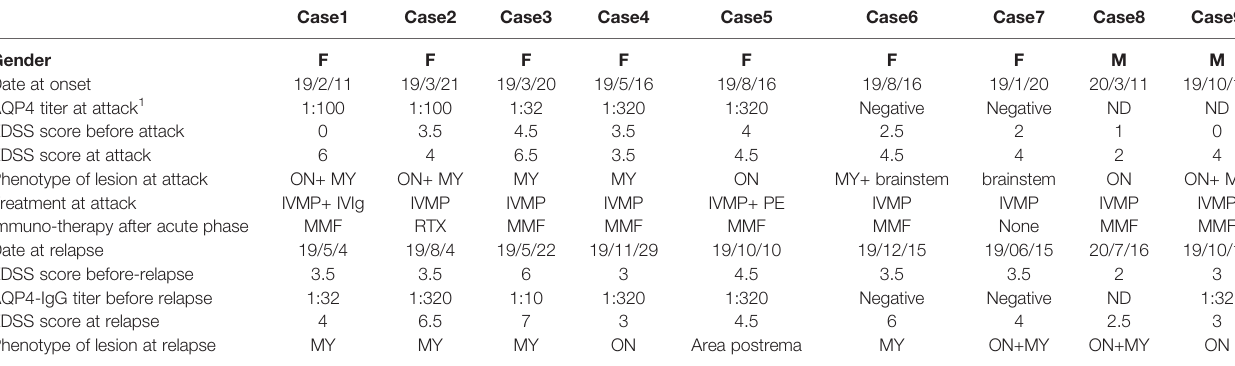
TABLE 2 | Clinical characteristics of 9 NMOSD patients who experienced recurrences during the 6 months.